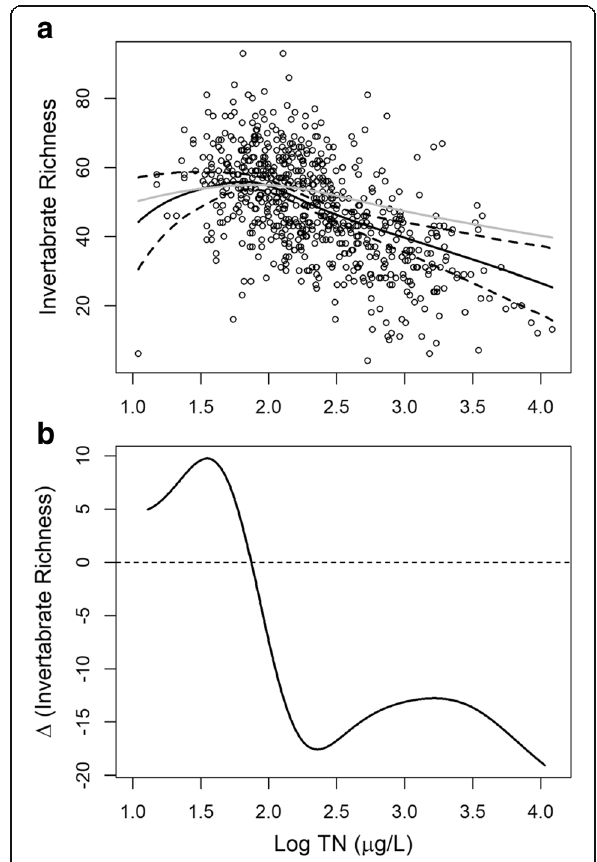
Fig. 3 a The regional causal effects of total nitrogen on invertebrate richness in the Western United States. The black solid line and the black dashed lines are the mean estimations by generalized propensity score of the TN-IR dose-response function and the corresponding 95% confidence boundaries, respectively. The gray solid line is the estimation by GAM. b The change rate (slope) of invertebrate richness at different nitrogen